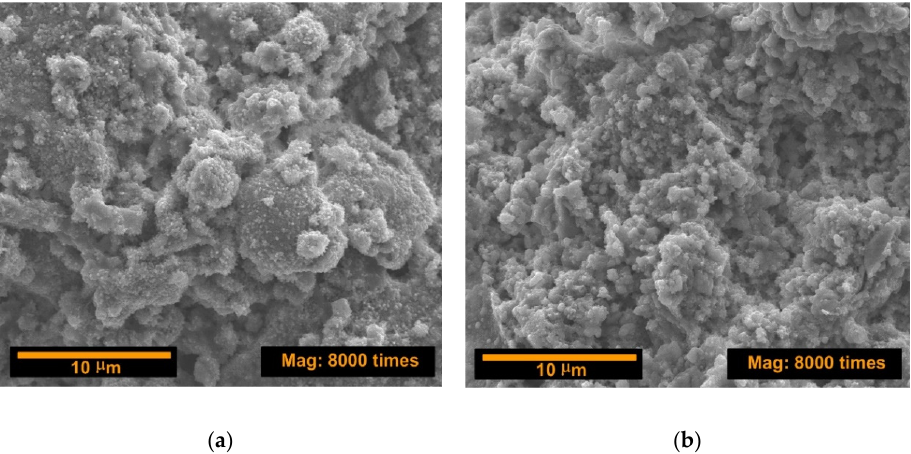
Figure 9. SEM picture of a cement matrix after 8 h of curing: ( a ) without the C-S-H seeds; ( b ) containing the C-S-H seeds.